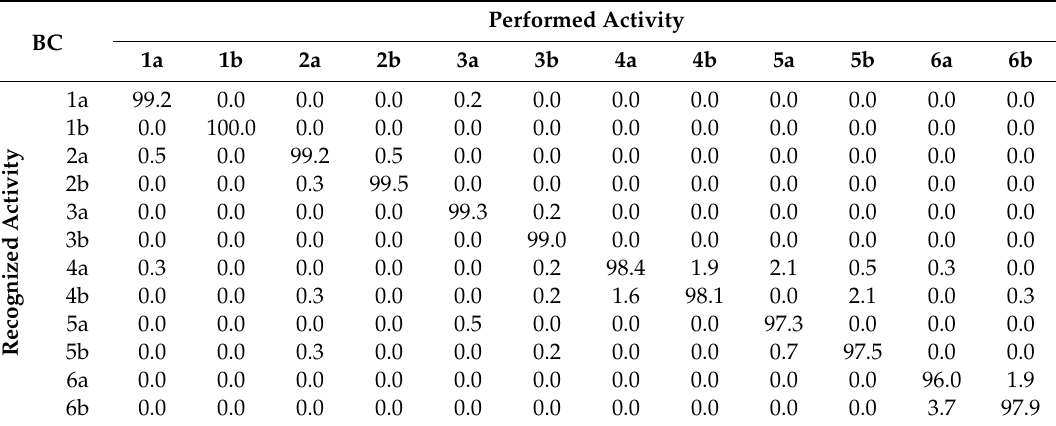
Table A1. Table of recognition errors (in %) of 12 motor activities 1a ÷ 6b in test set for all volunteers together for sensor BC.